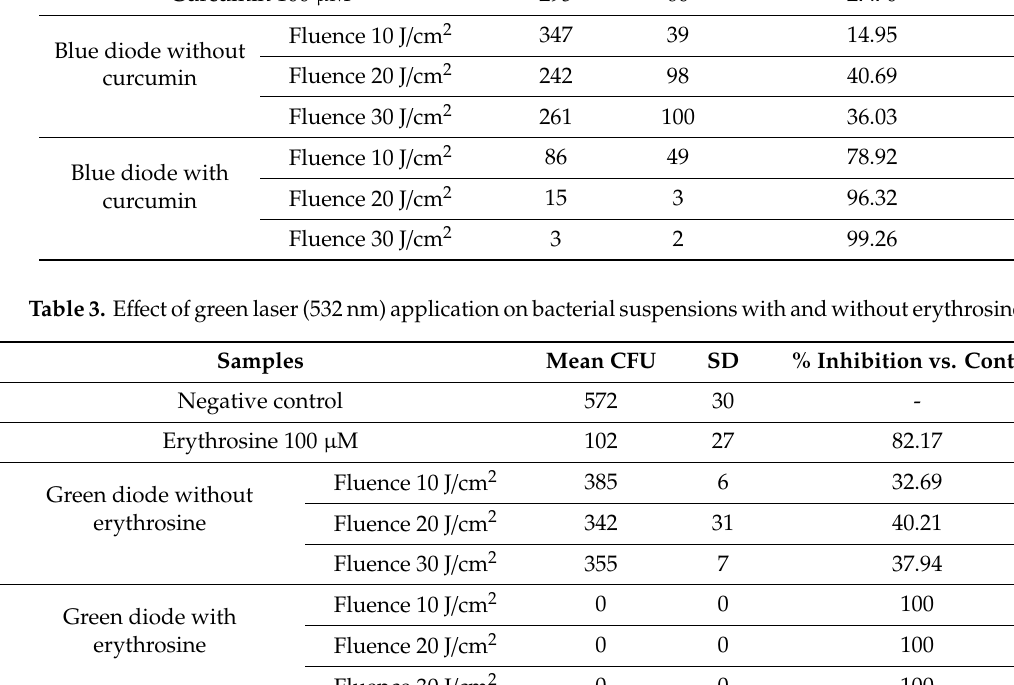
Green diode with erythrosine